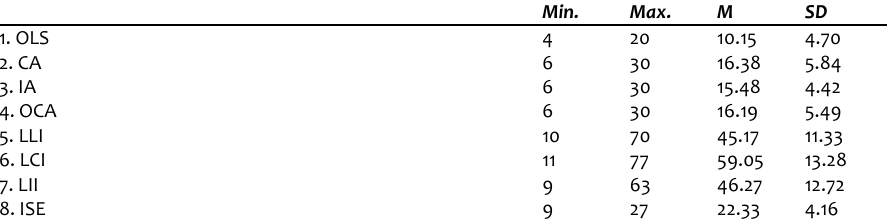
Table 2. Descriptive Statistics of the Variables